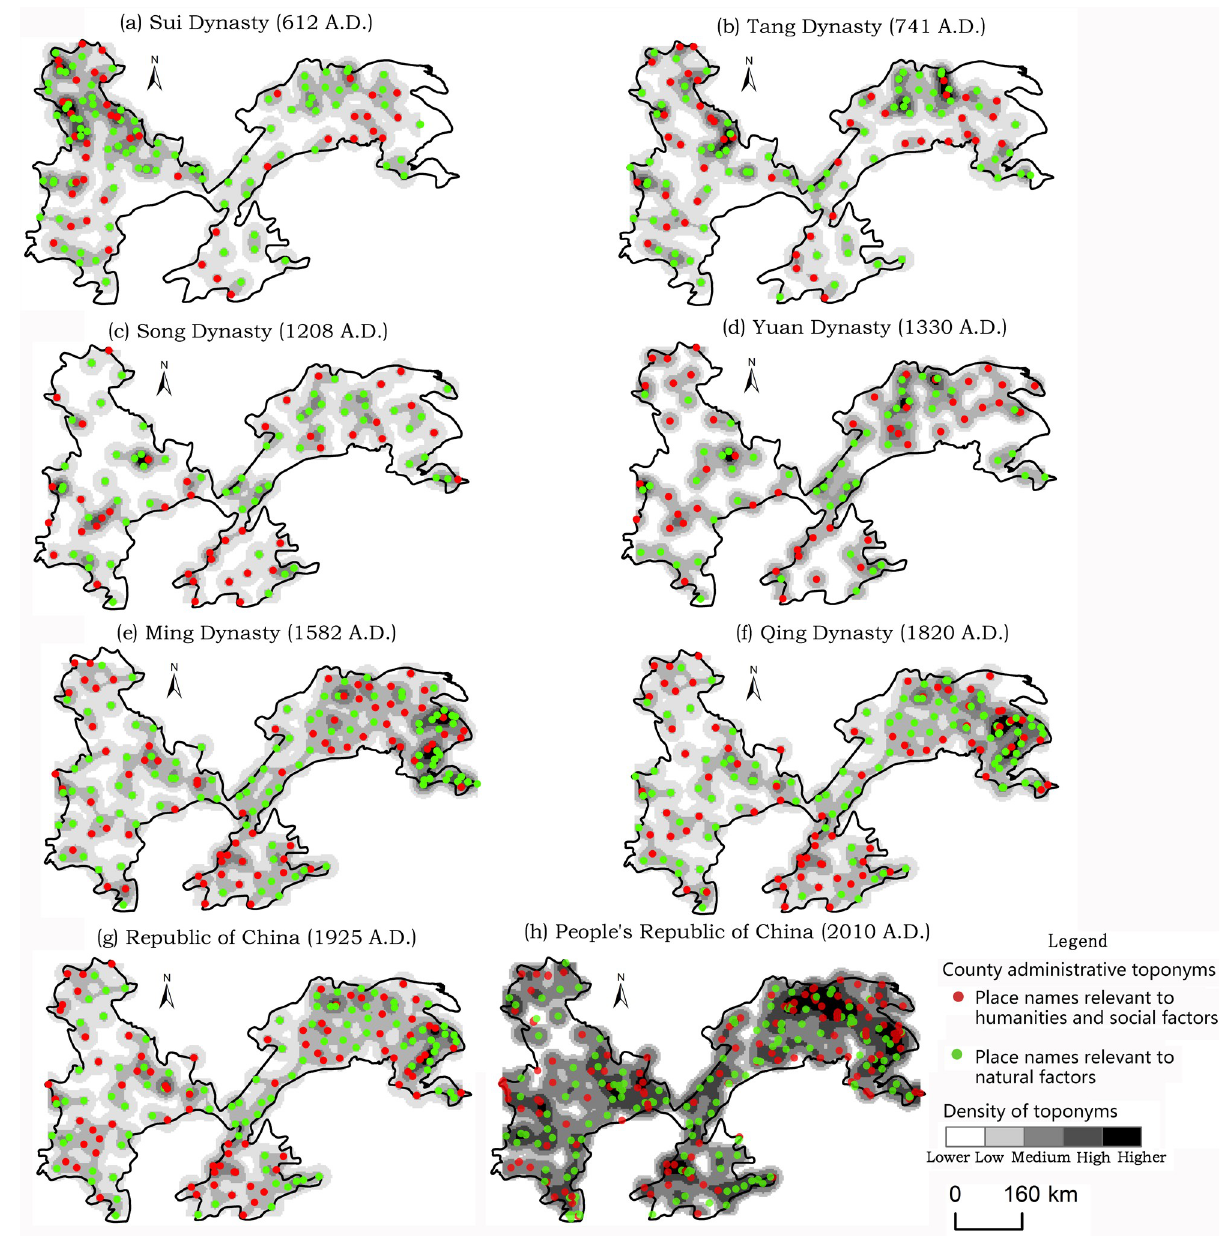
Fig 6. Spatio-temporal evolution of county-level administrative toponyms in the Yangtze Plain since the Sui dynasty.